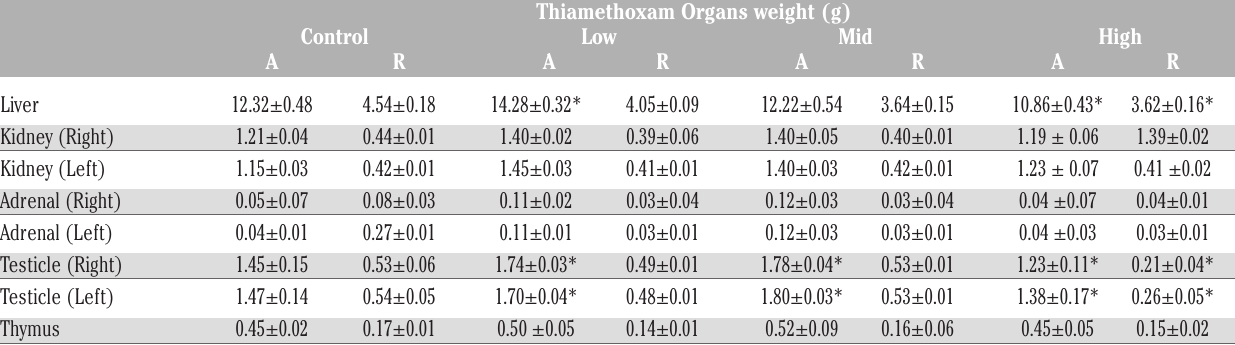
Table 2. Effects of thiamethoxam (TMX) on absolute and relative organ weights in the control and TMX-treated groups.